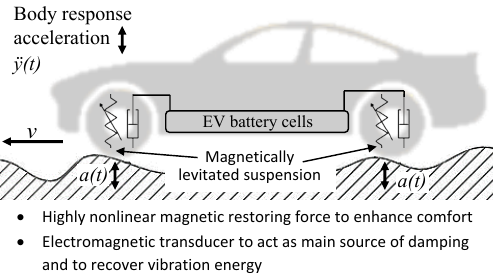
Figure 1. Concept of a car with a magnetic suspension and an electromagnetic energy recovery system while driving on rough roads.